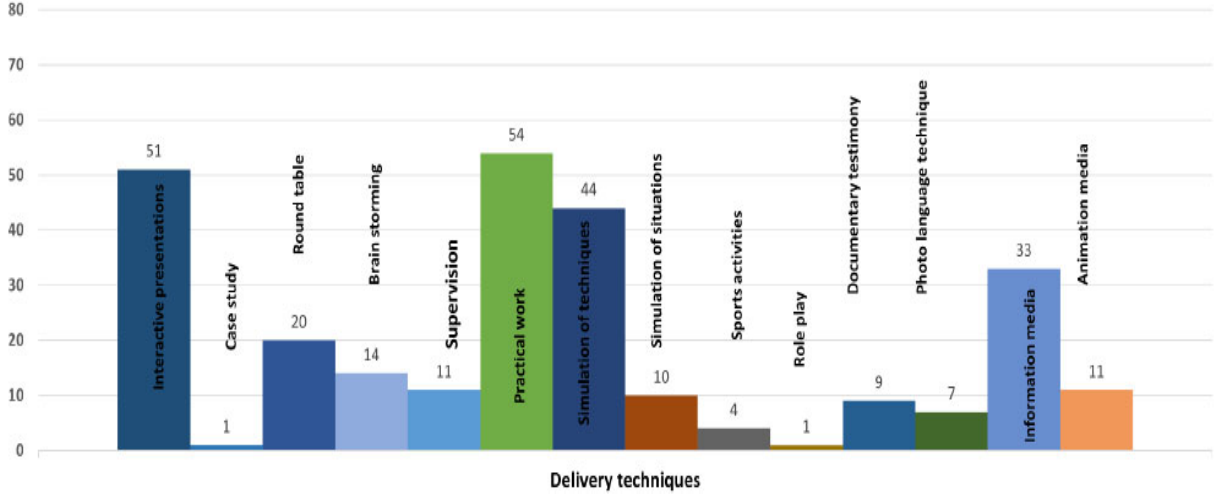
Figure 2. Delivery techniques for TPE